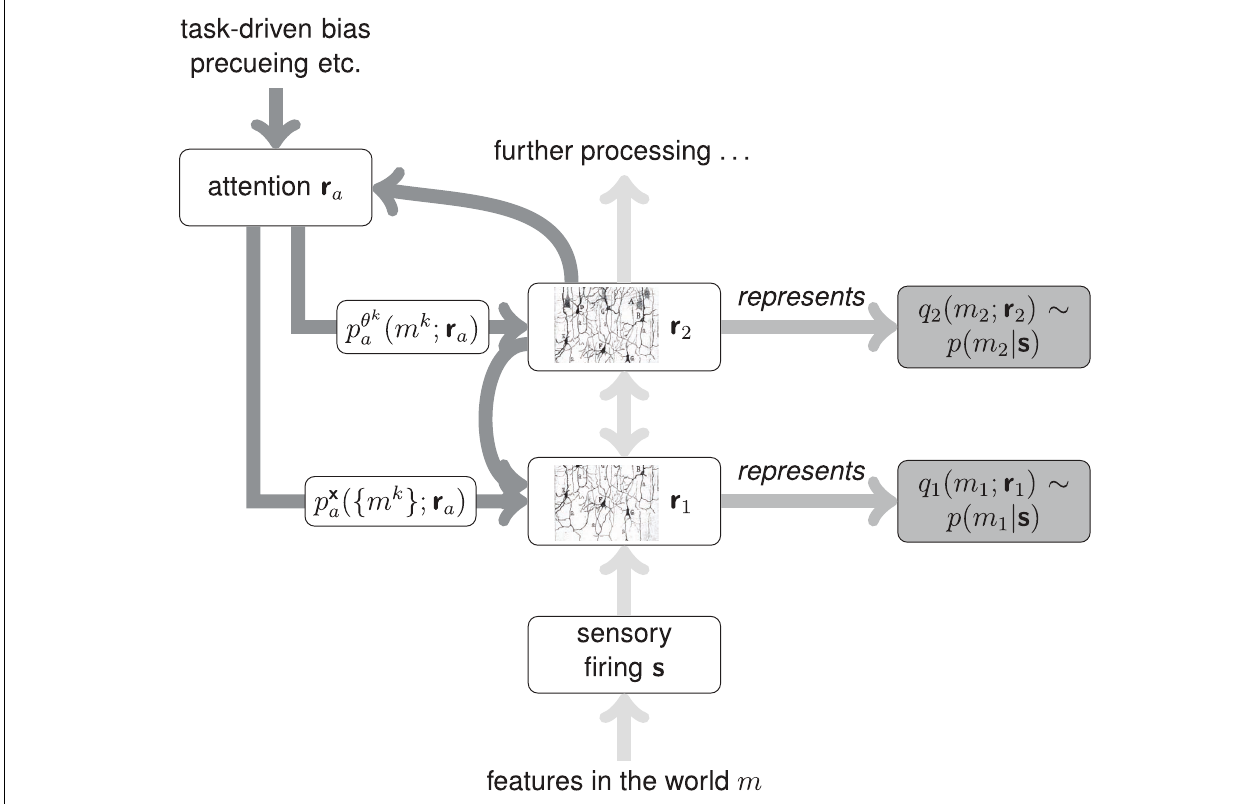
FIGURE 7 |A simple schematic of a neural framework for top-down attentional